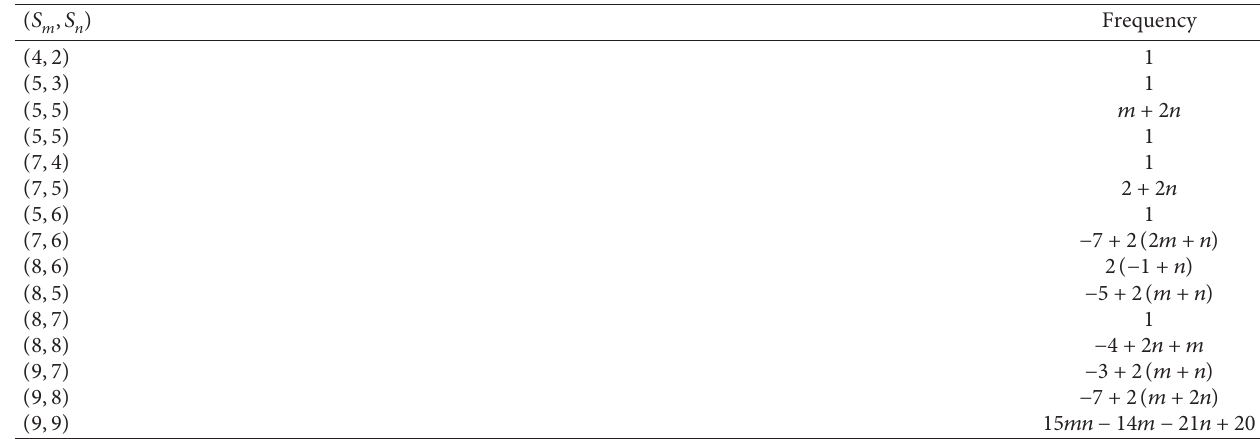
− I [ m,n ] with m, n ≥ C 2 3